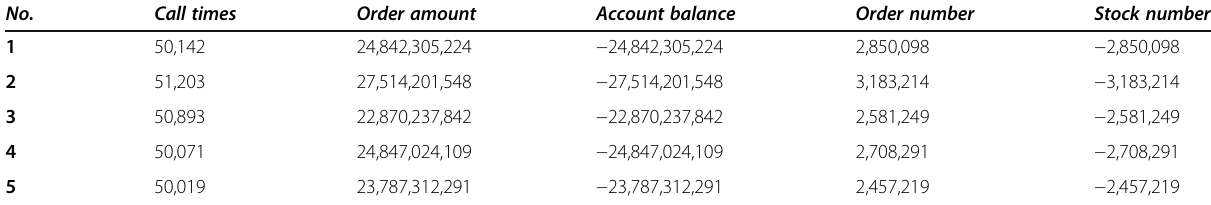
Table 7 Data consistency experiment